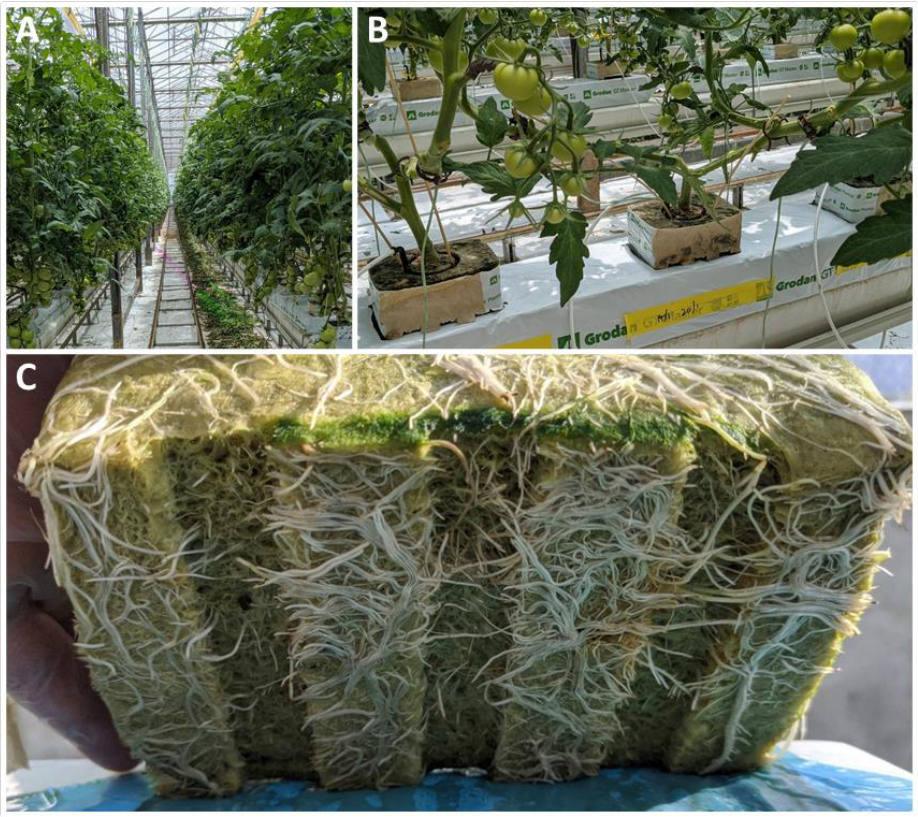
Microorganisms 2023 , 11 , x FOR PEER REVIEW Figure 2. ( A ) Typical growing arrangement in a commercial glasshouse; ( B ) young tomato plants on rockwool slabs; ( C ) rockwool propagation block with roots of young tomato plant (images: Phil Thomas).